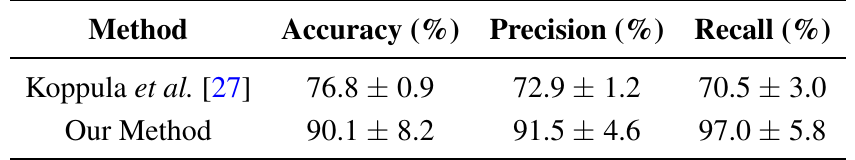
Table 8. Comparison of our approach with Koppula et al. [27] for the CAD-120 dataset (Cornell Activity Dataset) sub-activity recognition. Average Accuracy, Precision and Recall.